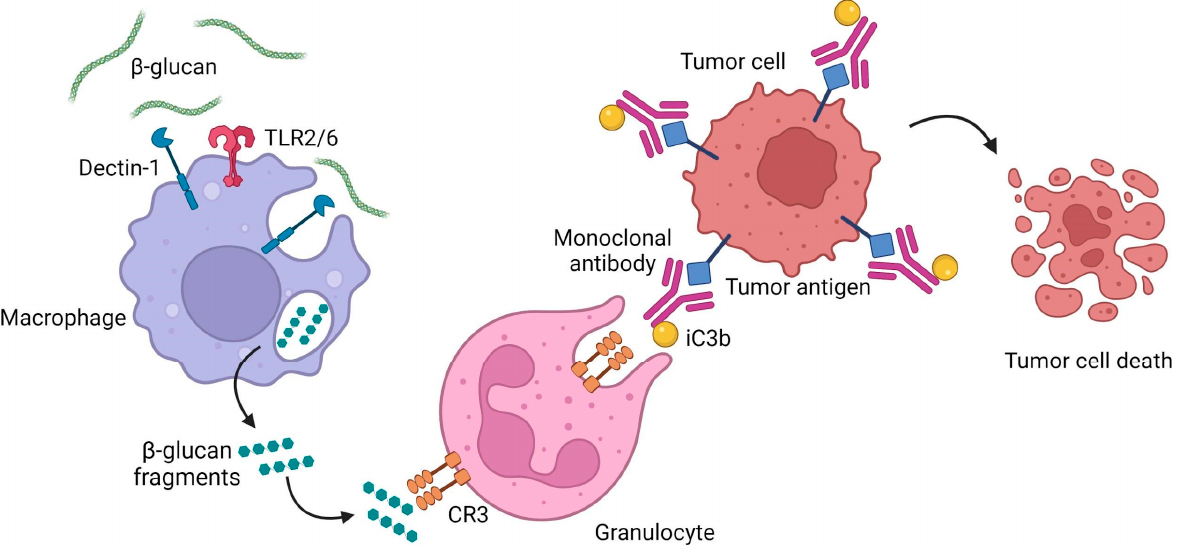
Figure 6. Complement-dependent antitumor cytotoxicity mediated by β -glucans. Due to the lack of β -glucans, tumor cells are not able to induce dual binding to leukocytes, promoting complement-dependent cytotoxicity. However, the introduction of exogenous β -glucans can generate dual-binding of leukocytes to iC3b-positive tumor cells. β -glucans are captured and internalized by the macrophages via the Dectin-1 receptor with or without TLR-2/6. The large β -glucan molecules are fragmented into smaller sized β -glucan fragments within the macrophages and are carried to the marrow and endothelial reticular system and subsequently released. These small β -glucan fragments are eventually recognized by the circulating granulocytes, monocytes or macrophages via the complement receptor (CR)-3, priming leukocytes against tumor cells opsonized with iC3b by monoclonal antibodies.